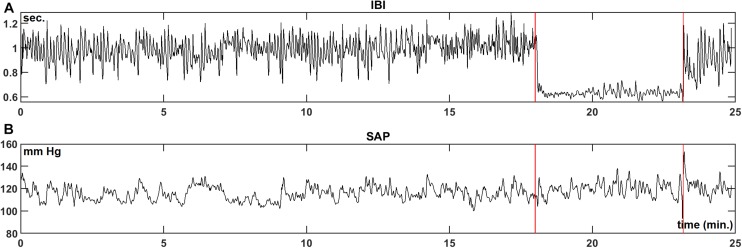
Example registration of IBI (A) and SAP (B) data for a resting supine subject, who is passively moved to a 70° head-up-tilt position and back (between the vertical lines). In this case, a large increase in heart-rate during HUT is observed, while the blood pressure level is hardly affected.